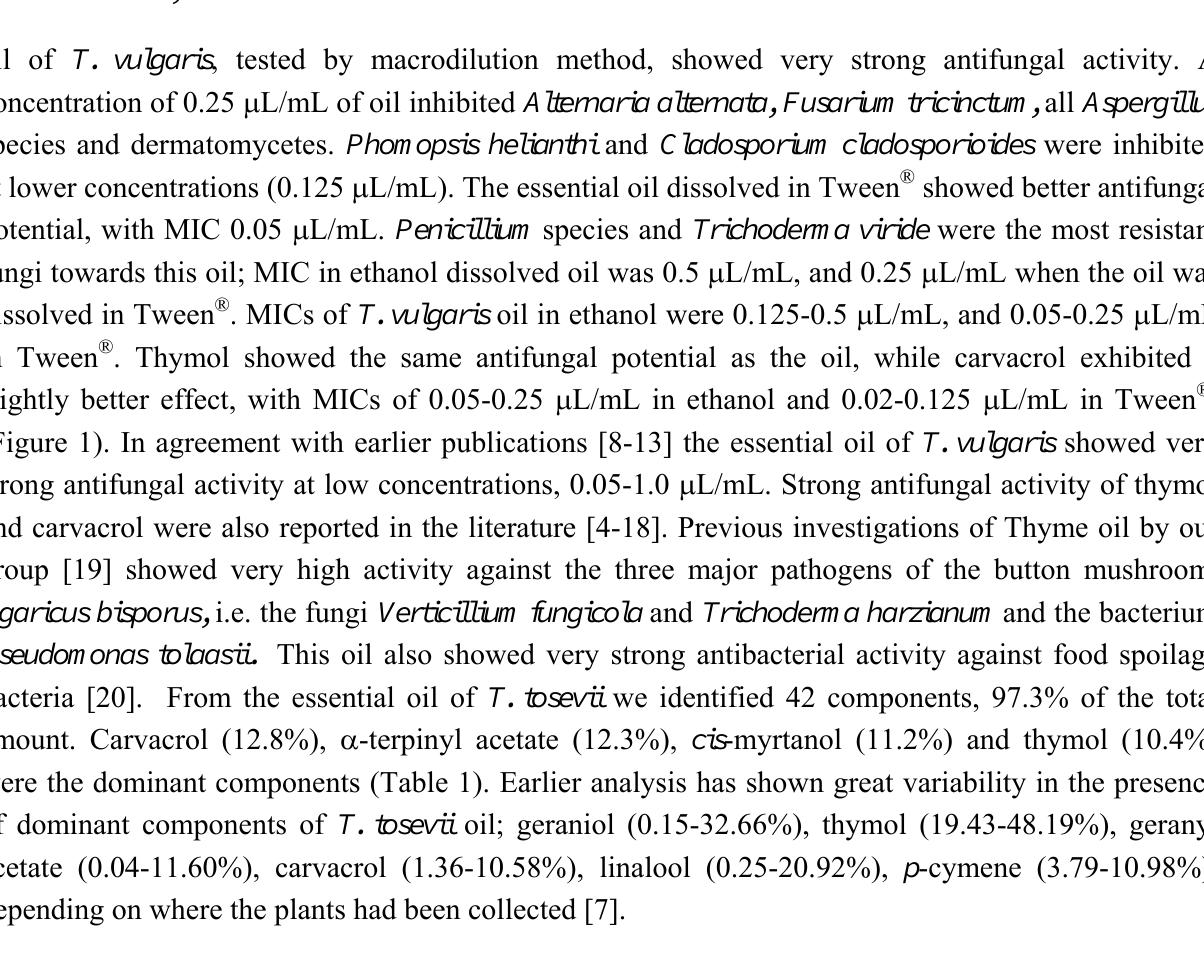
Table 1. Composition of the essential oils of Mentha and Thymus